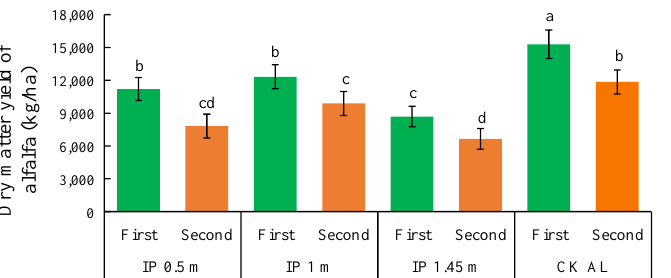
Figure 9. Dry matter yields of alfalfa under different treatments. The first and second in the abscissa are the abbreviation of the first full-bloom stage and the second full-bloom stage, respectively.